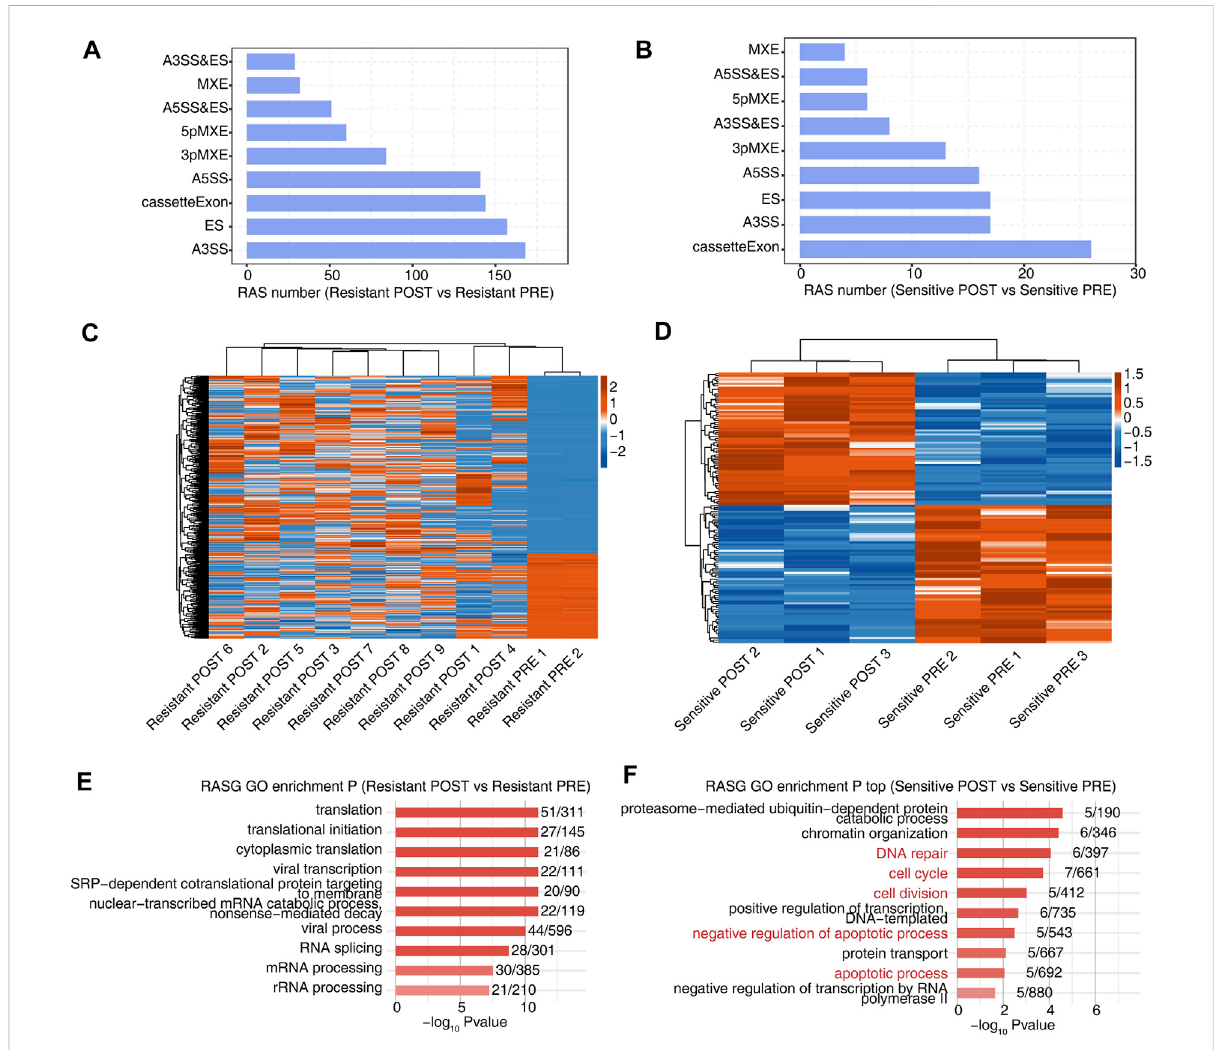
samples. X -axis:NIRRASEnumber. Y -axis:thedifferenttypesofASevents. (B) Thebarplotshowingthenumberofallsigni fi cantregulatedalternative splicing events between Sensitive POST and Sensitive PRE samples. X -axis: NIR RASE number. Y -axis: the different types of AS events.